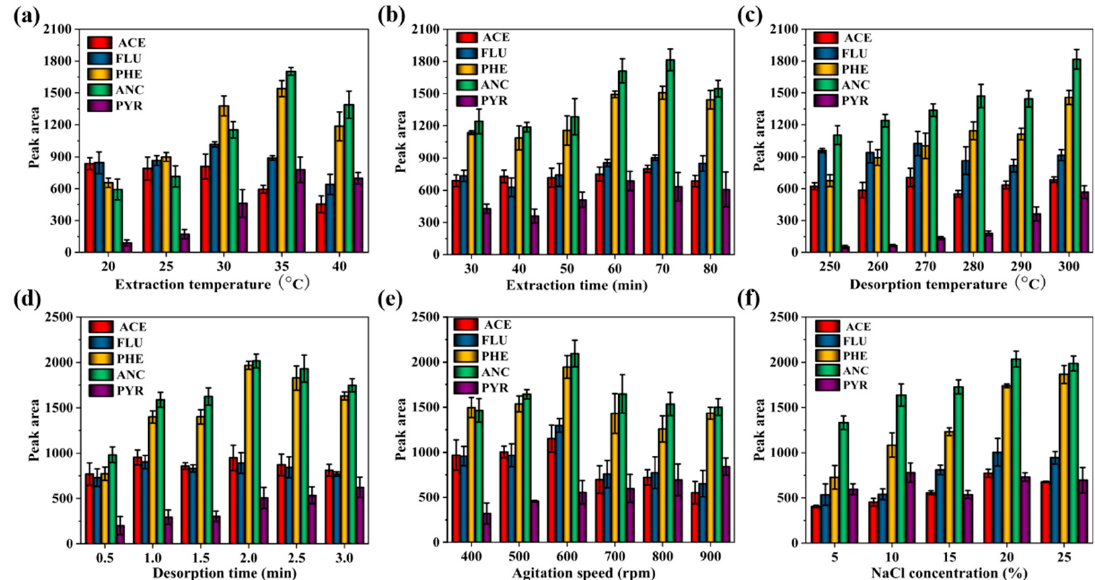
Figure 4. The influence of experimental conditions on extraction efficiency for the PAHs obtained on the h-BN-coated fiber. Extraction temperature ( a ); extraction time ( b ); agitation speed ( c ); desorption temperature ( d ); desorption time ( e ); and NaCl concentration ( f ).